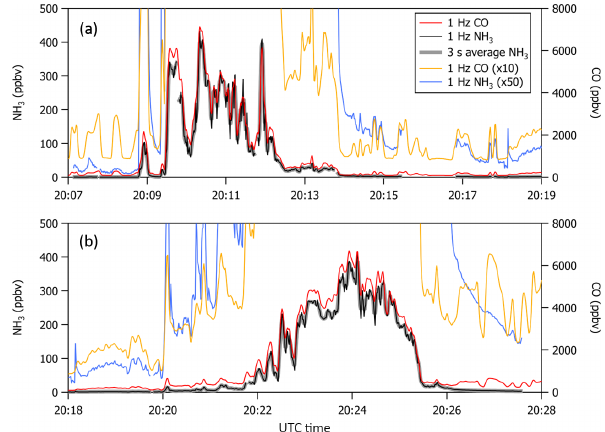
Figure 10. Time series of 1Hz NH 3 (black lines) and CO (red lines) measured during a crosswind transect of the smoke plume from the South Sugarloaf Fire (RF15) on 26 August 2018. The transects rep- resent nearly identical passes through the smoke plume with the only perturbation of the NH 3 instrument being operated (a) with passivant and (b) without passivant. Changes in fine structure fea- tures of NH 3 have the strongest R 2 correlation with CO when the NH 3 measurements are averaged to 3s. A × 50 magnified view of 1Hz NH 3 (blue lines) and a × 10 magnified view of CO (orange lines) show differences in background levels of NH 3 compared to CO before and after each plume